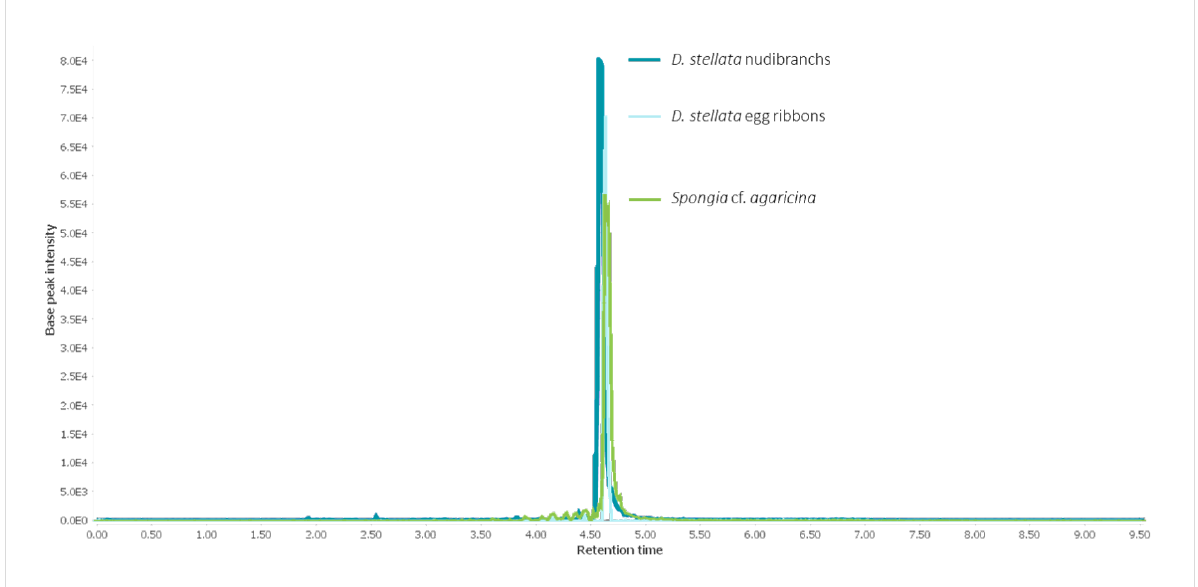
extracts, as well as the isolated new scalarane, showed antibac- terial activity against the Gram-positive bacteria Arthrobacter crystallopoietes (DSM 20117) and Bacillus megaterium (DSM 32), in a screening approach.